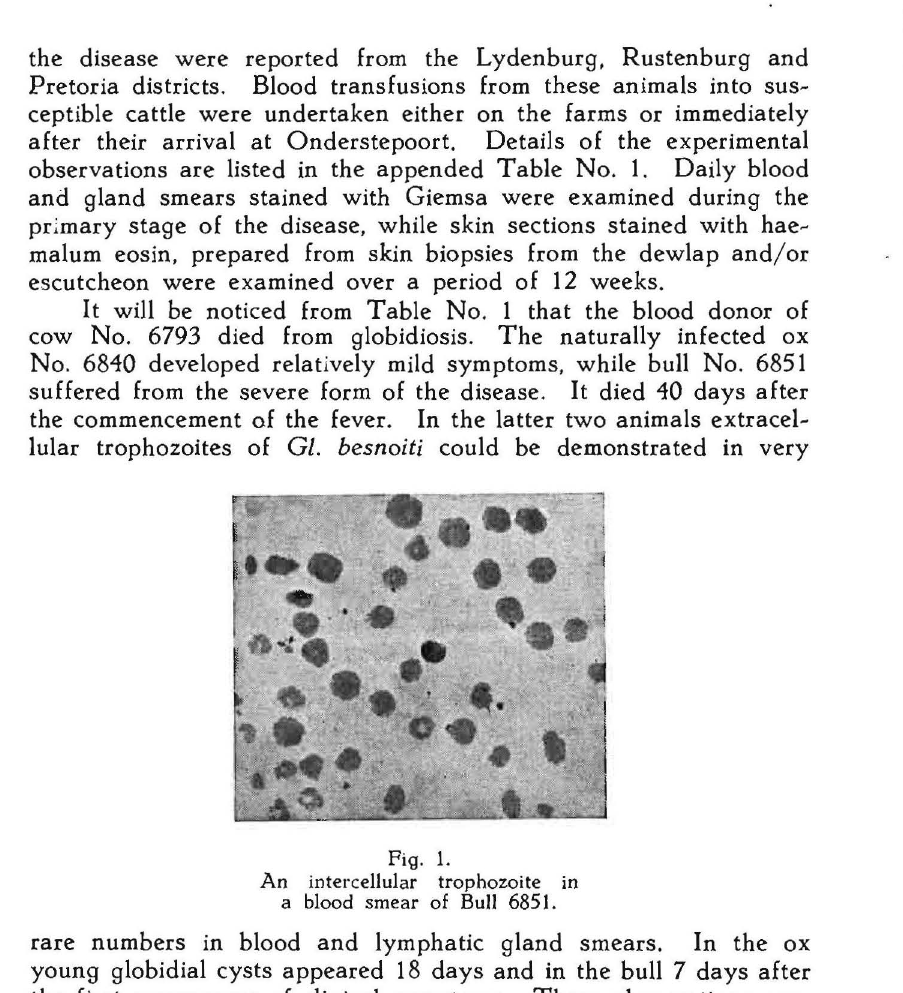
Fig. I. An intercellular trophozoite in a blood smear of Bull